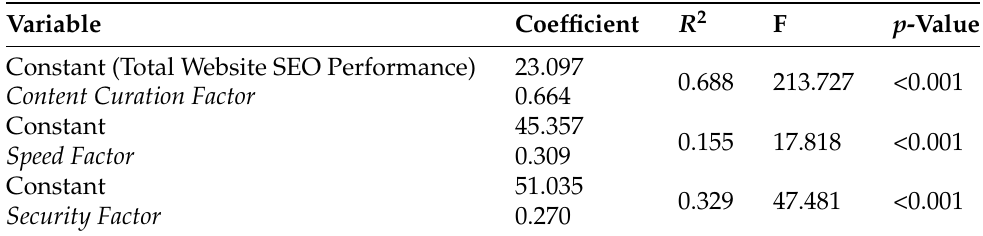
Table 8. Regression equation output of websites with Drupal CMS and their change in each pro- posed